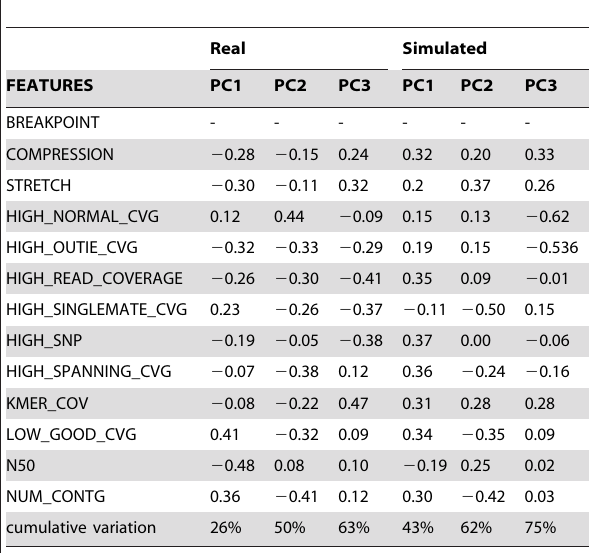
Table 3. More Informative Principal Components For Short Reads.